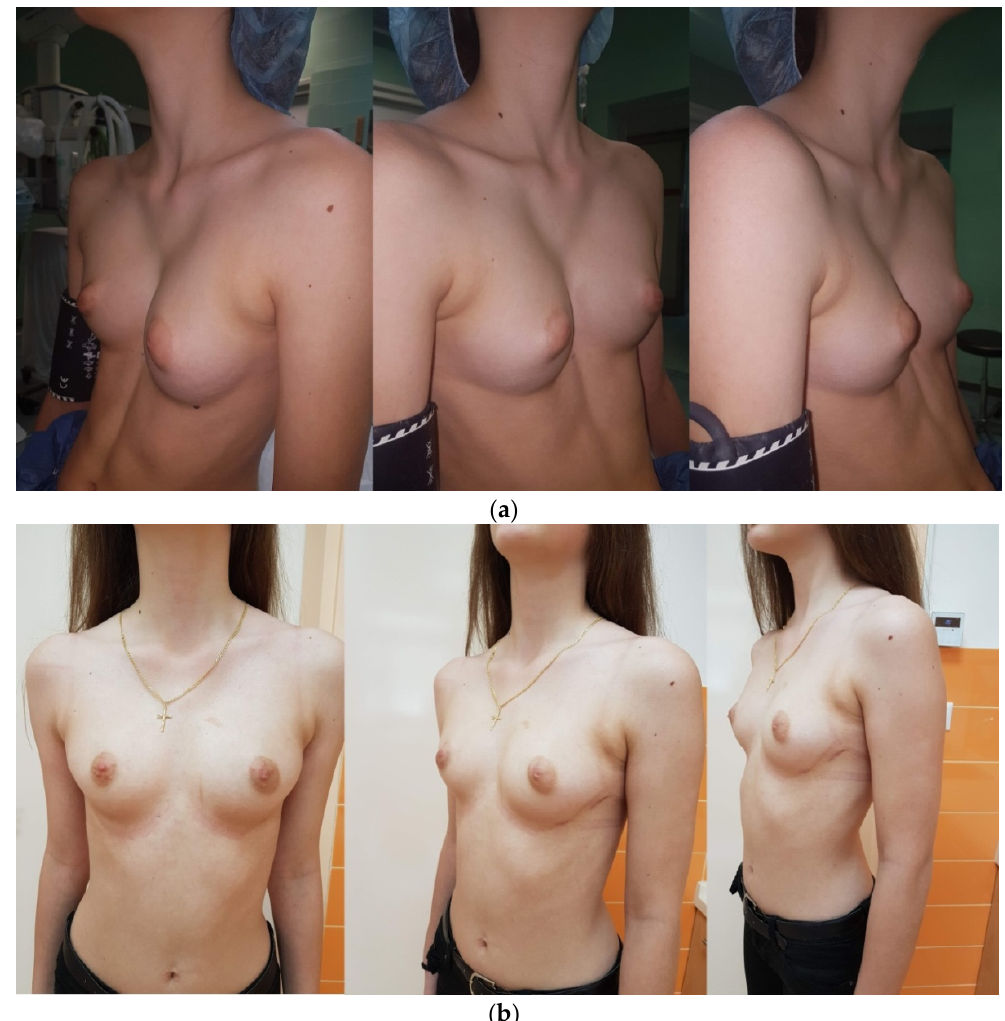
Figure 2. ( a ) Preoperative presentation of 15-year-old female patient with pectus excava- tumscheduled for corrective Nuss procedure. ( b ) Postoperative result of the same patient two weeks after